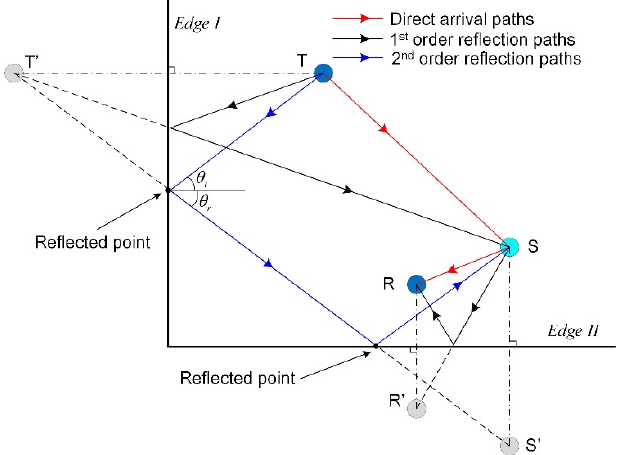
Figure 1. Schematic diagram of the traveling paths of some scattering wave packets from the transmitter to the scatterer to the receiver. The symbol “T” denotes the transmitter, “S” denotes the scatterer, and “R” denotes the receiver. “T ”, “R ”, and “S ” denote the corresponding mirror points of “T”, “S” and “R”.